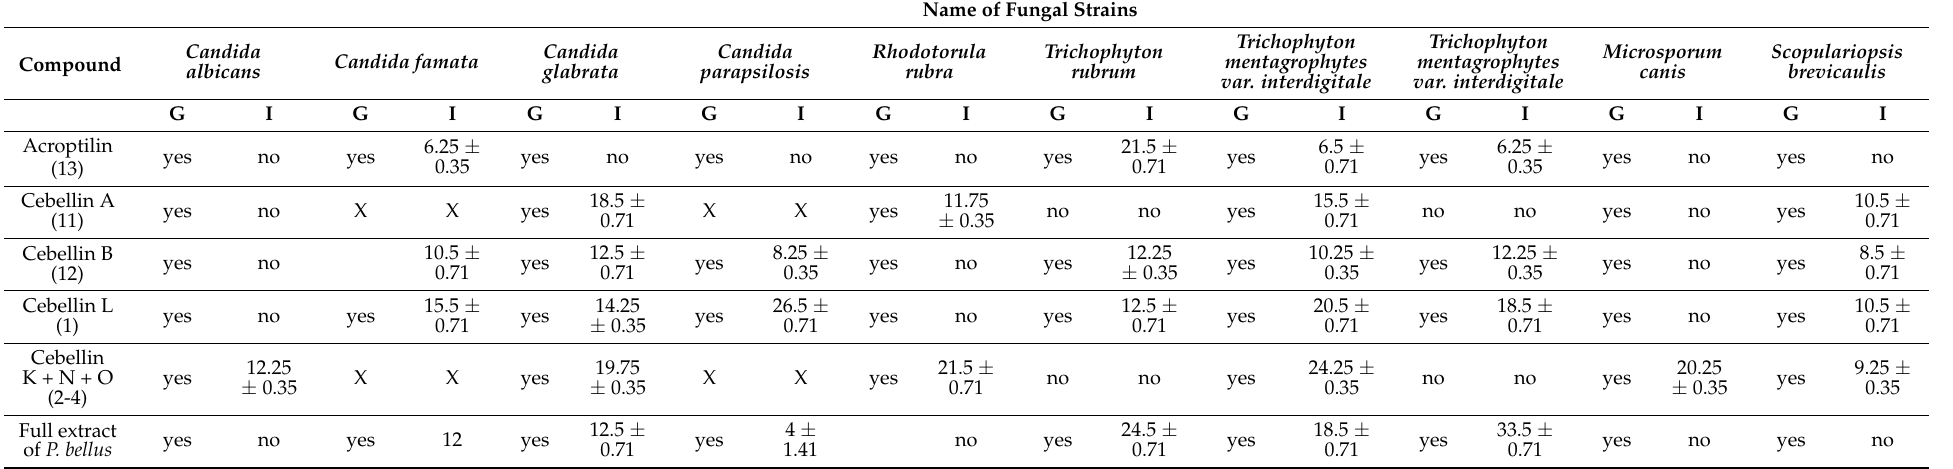
Table 2. The results of the antifungal activity of the examined compounds from P. bellus (growth inhibition zone (mm) ± standard